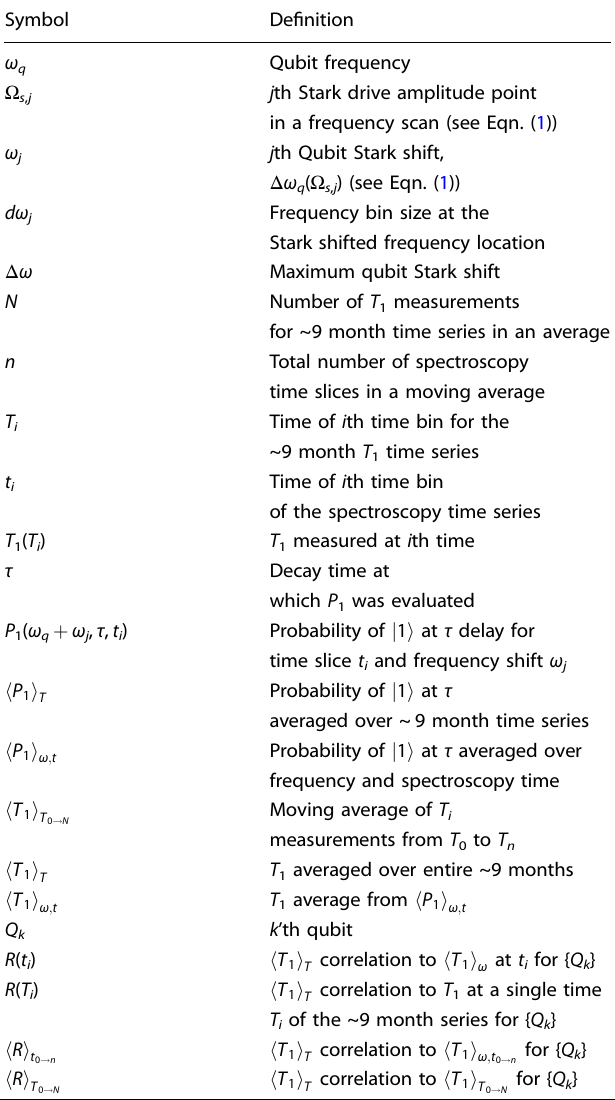
Table 1. List of